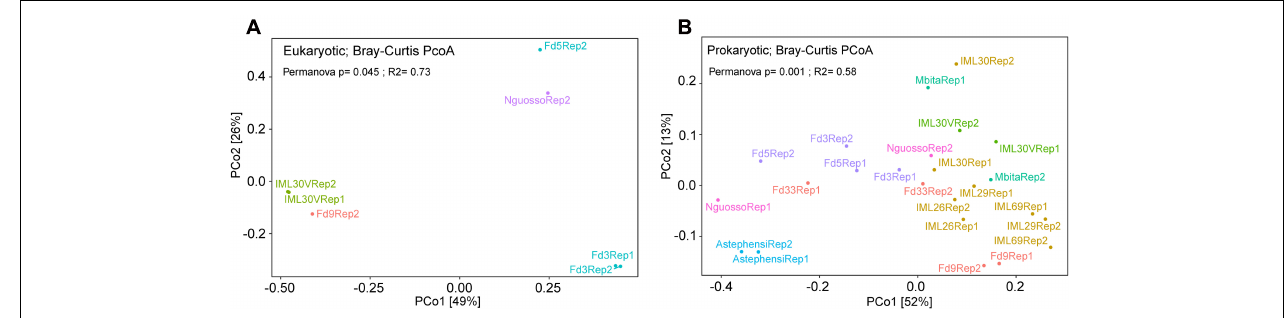
FIGURE 9 | Principal Coordinate Analysis (PCoA) for microbial diversity in laboratory colonies of Anopheles . Co-housed Anopheles colonies maintain diversity for their (A) eukaryotic and (B) prokaryotic microbiomes. PCoA for the eukaryotic microbiome of seven colony samples with greater than 900 sequence reads following rarefaction. (B) PCoA for the prokaryotic microbiome of laboratory colonies. All colonies were sampled for both eukaryotic and prokaryotic microbiomes, but only those samples yielding adequate sequence information were analyzed (10,000 sequences per sample for 16S rRNA gene data and 900 sequences per sample for 18S rRNA gene data). Both plots highlight the similarity eukaryotic and prokaryotic microbial profiles across experimental replicates (all data points are labeled either Rep1 or Rep2). The variable tested in the Permanova was the colony of origin of lab